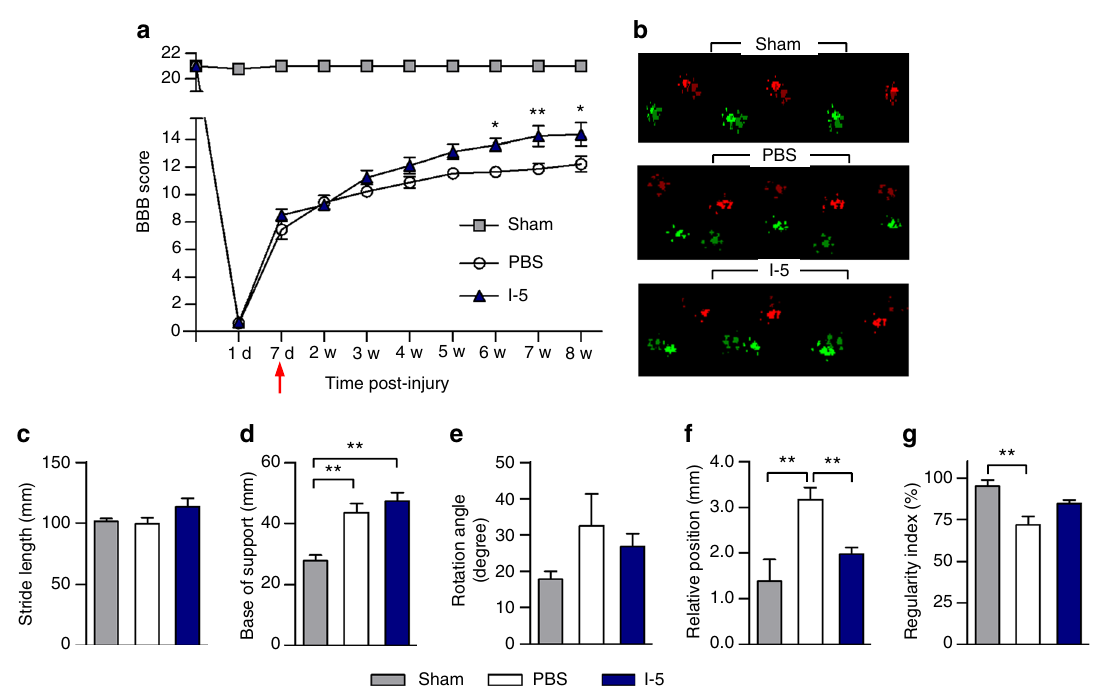
Fig. 8 Injection of I-5 hydrogel promotes locomotor recovery. a Comparison of locomotor recovery in the PBS and I-5 injection groups. Locomotor recovery was measured by using the BBB scale in an open fi eld. Animals with I-5 injection showed improved BBB locomotor scores from 4 weeks after injury. A red arrow indicates the day of injection. * and ** Indicate p < 0.05 and p < 0.01, respectively, by repeated measures two-way ANOVA followed by post hoc Bonferroni analysis. N = 9 for the PBS group and N = 8 for the I-5 groups. Error bars represent the SEM. b Representative footprints analyzed by the Catwalk software. The colors of the footprints were assigned by the Catwalk software ( bright red = left forepaw, dim red = left hindpaw, bright green = right forepaw, and dim green = right hindpaw). c – g Five parameters were used to quantify the quality of locomotion 7 weeks after injury. c Stride length. d Base of support. e Rotation angle. f Relative position. g Regularity index. ** indicates p < 0.01 by one-way ANOVA followed by Tukey ’ s post hoc analysis. N = 5, 9 and 8 for the sham, PBS, and I-5 groups, respectively. Error bars represent the